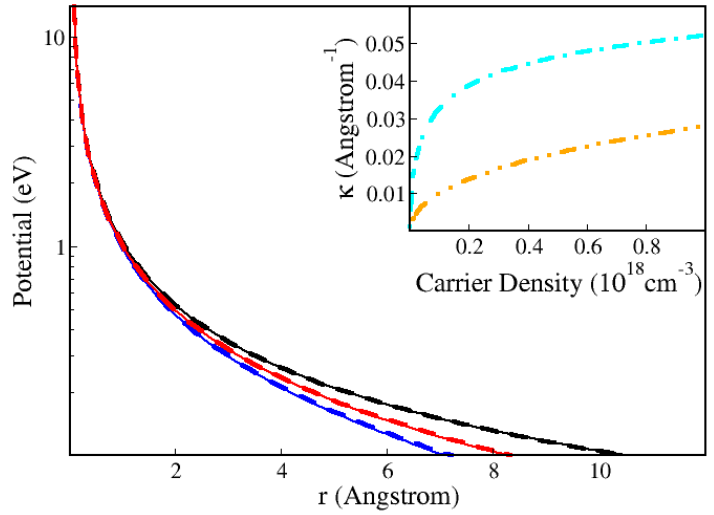
Figure 3. Comparison of the Hulthén (dashed lines) and Yukawa (thin solid lines) potentials as a function of distance. The black curves are for T = 10 K and N = 10 10 carriers/cm 3 . The blue curves are for T = 10 K and N = 10 18 carriers/cm 3 and the red curves are for T = 300 K and N = 10 18 carriers/cm 3 . Both cases depend on the temperature T and carrier density N through the inverse screening length κ and the inset explains the results, because κ increases with increasing carrier density and with decreasing temperature. The dot-dashed (cyan) curve is for T = 10 K, while the double-dot-dashed (orange) curve is for T = 300 K.